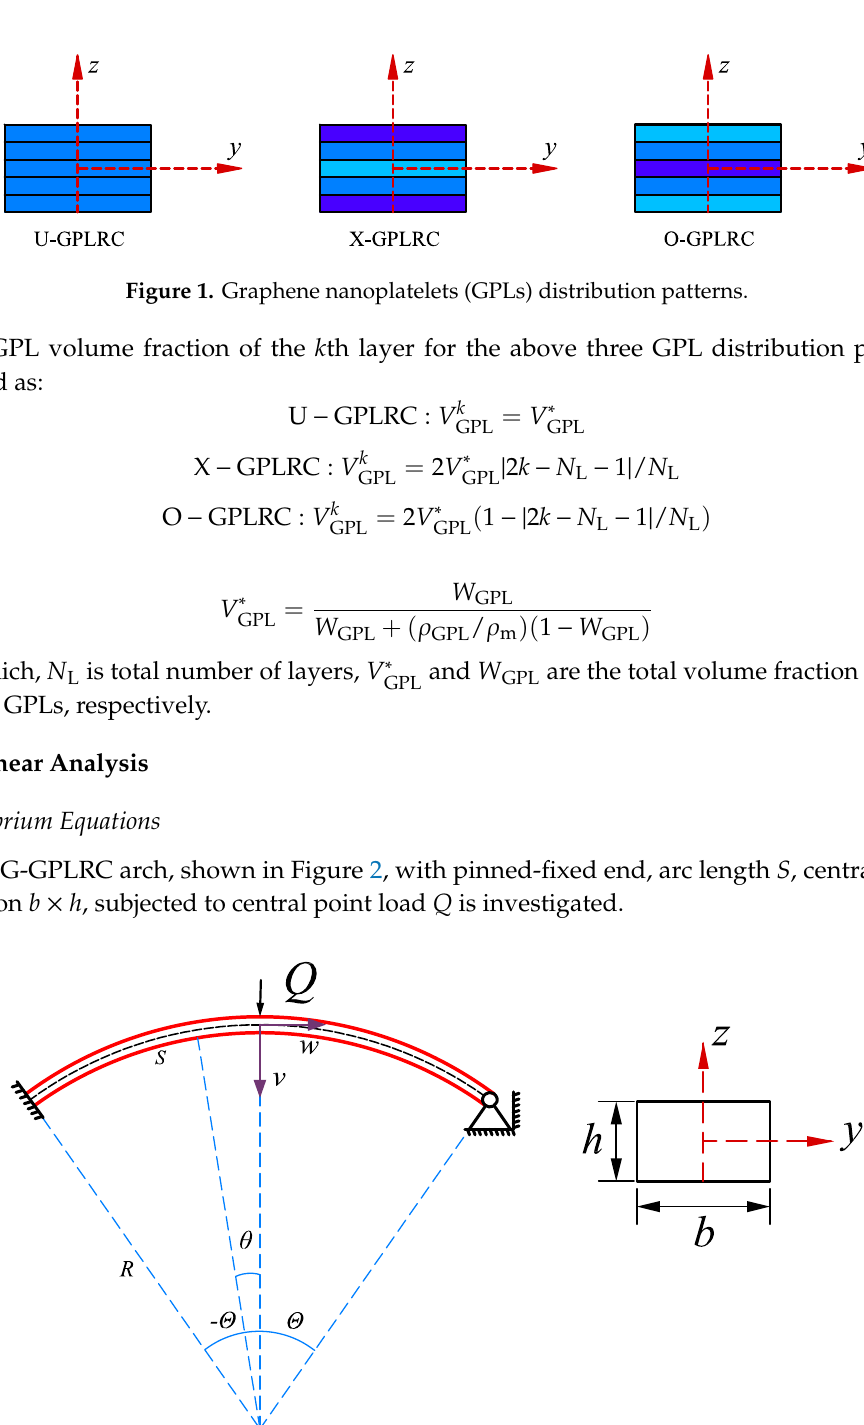
Figure 1. Graphene nanoplatelets (GPLs) distribution patterns.